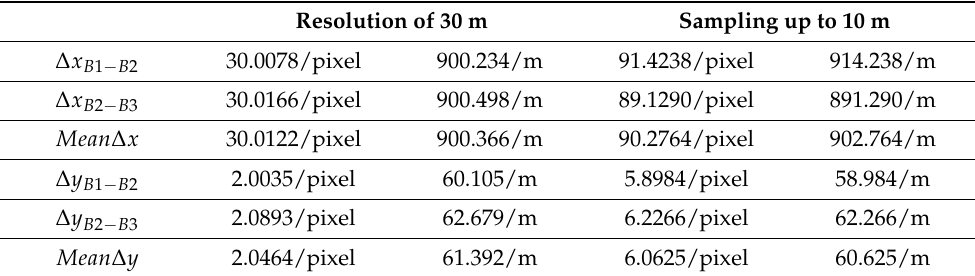
Table 2. The horizontal and vertical pixel offsets of two adjacent band